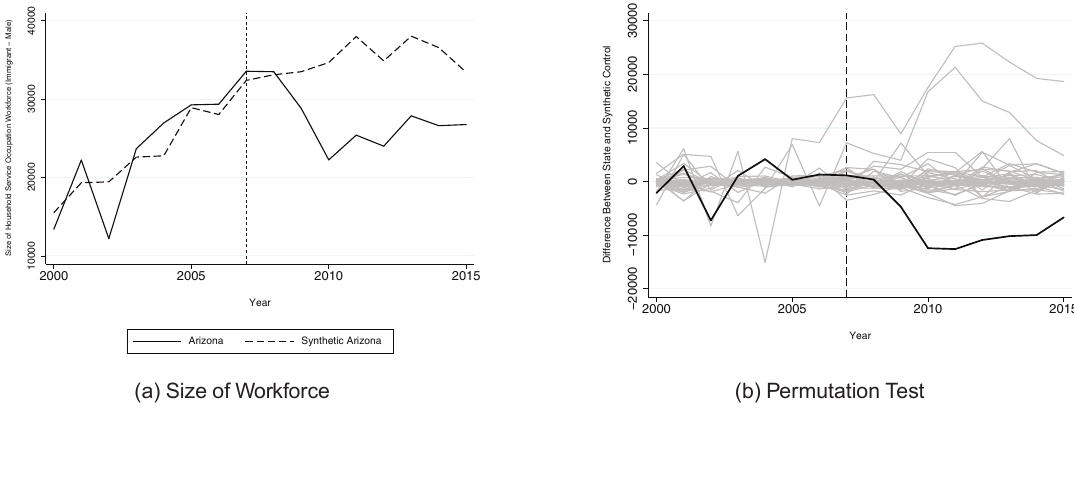
Figure A25 Size of immigrant workforce (male) in household service occupations